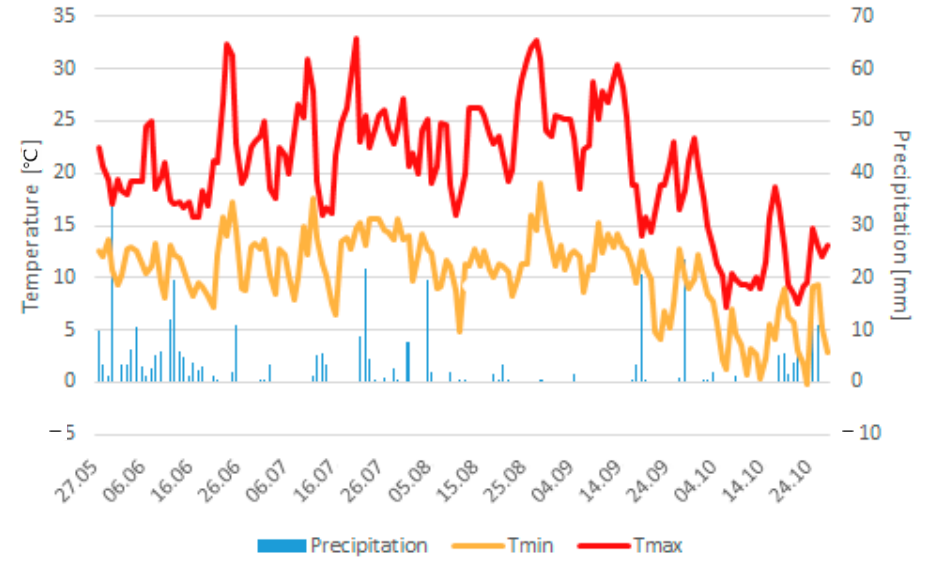
Figure 2. Precipitation (mm; bars) and minimum and maximum temperature (°C; lines) during the experimental period at Ihinger Hof in 2018 (May–October).